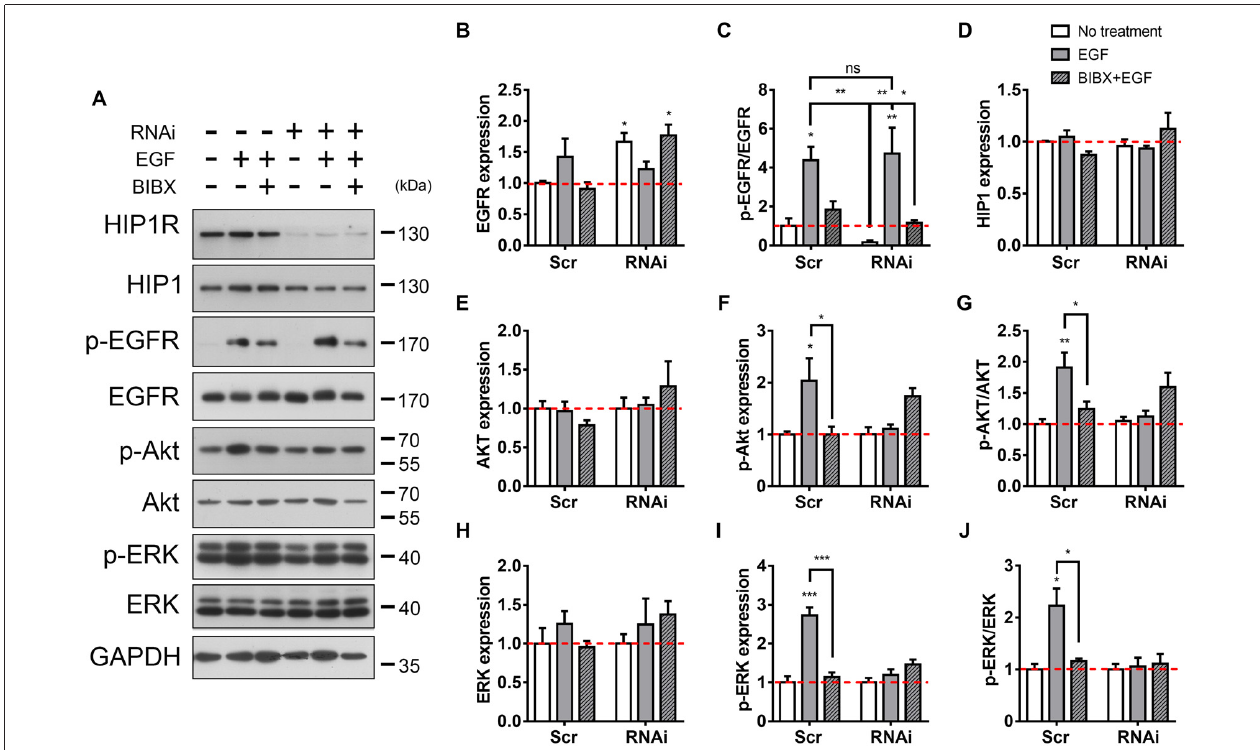
FIGURE 6 | HIP1R knockdown attenuates EGFR downstream signaling. (A) The detection of EGFR and downstream Akt and ERK activity after EGF stimulation. (B) Quantitative analysis of EGFR expression after EGF stimulation in Scrambled and HIP1R-RNAi group. (C) Quantitative analysis of phosphorylated EGFR after EGF stimulation. (D) Quantitative analysis of HIP1. (E–G) Quantification of Akt (E) , p-Akt (F) and the ratio of p-Akt/Akt (G) level. (H–J) Quantification of ERK (H) p-ERK (I) and the ratio of p-ERK/ERK (J) level. Normalized by GAPDH and compared with untreated control. Mean ± SEM; ns, not significant; ∗ p < 0.05; ∗∗ p <